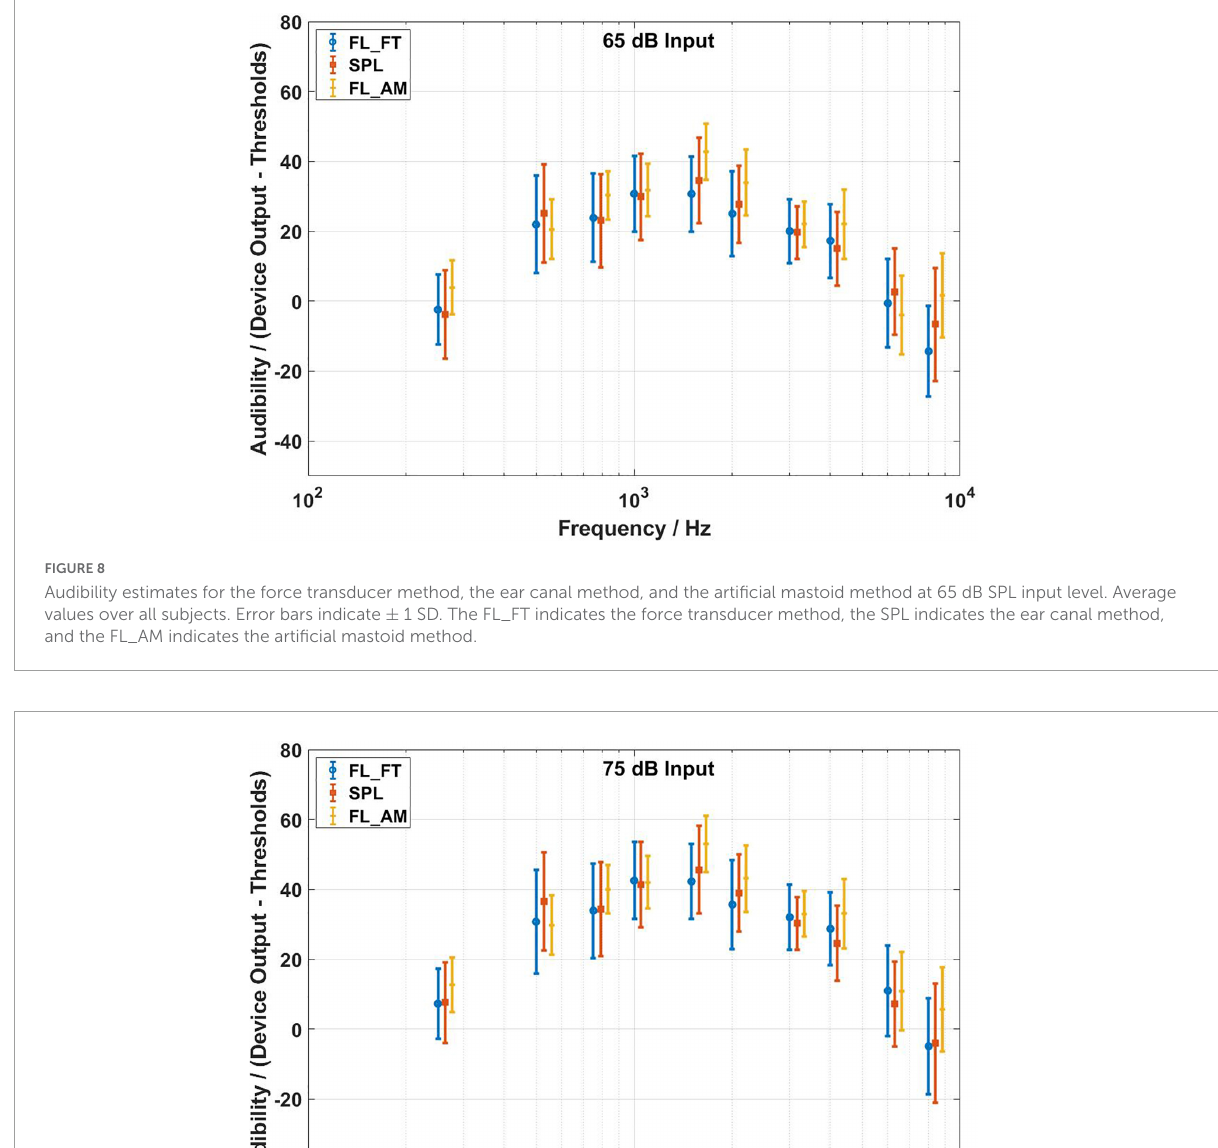
Figure 11 , the three solid lines are equal and far below the three dashed lines (except for 8,000 Hz). As can be seen in Figure 4 , the three solid lines in Figure 11 indicate the noise level of the force transducer measurement system. The results indicate that the force transducer is not influenced by the sound field signal when measuring the aided